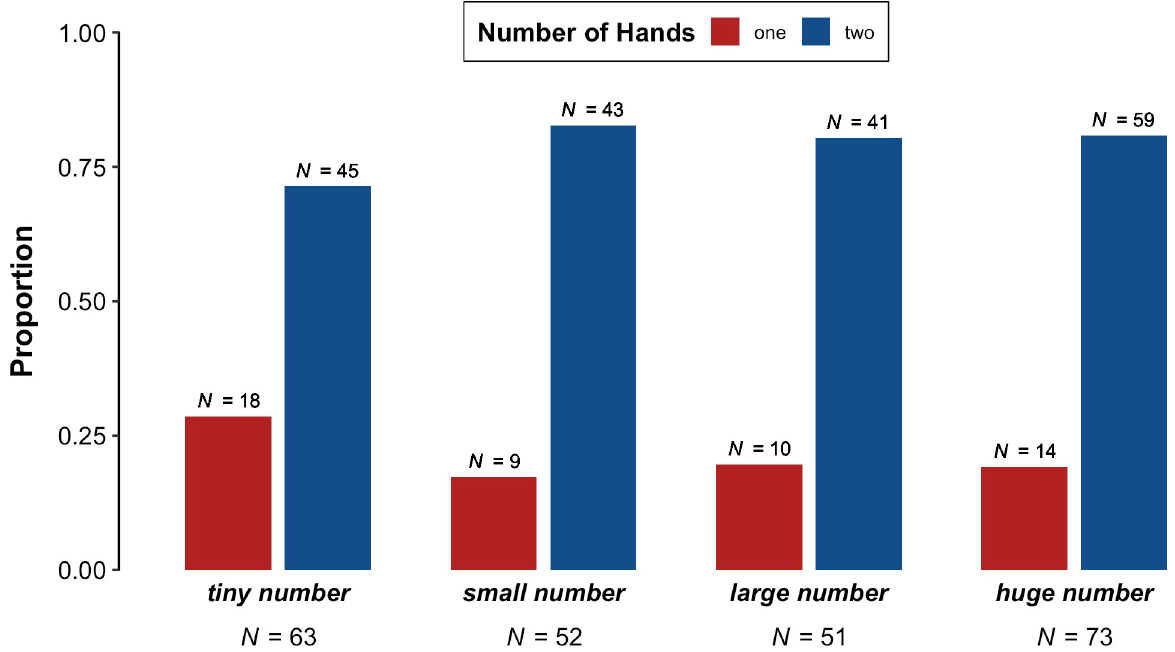
Fig 4. Proportion of videos in which both speakers’ hands were visible and free to gesture per phrase (’tiny number’, small number’, ’large number’, ’huge number’) that contained one-handed versus two-handed gestures.